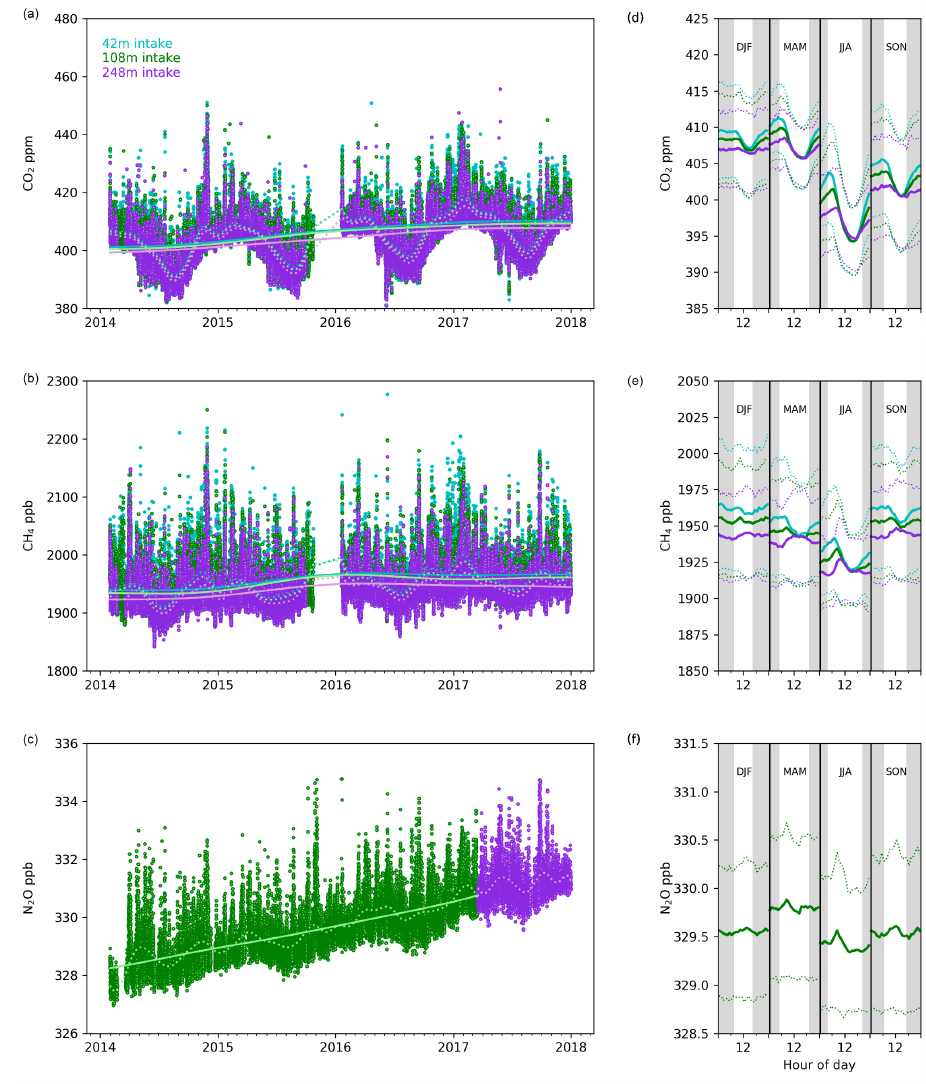
Figure 2. (a) – (c) Hourly mean of CO 2 (ppm), CH 4 (ppb), and N 2 O (ppb) measurements at three inlet heights (42, 108, and 248m) at Bilsdale, North Yorkshire, from March 2014 to July 2017 (Table 1). The statistical baseline (dashed line) and the long-term trend (solid line) are shown in the inset for each inlet height. (d) – (f) Mean seasonal diurnal cycle for CO 2 , CH 4 , and CO. The dotted lines denote the ± 5th and 95th percentile. Statistical fitting procedures follow Thoning et al. (1989); further details can be found in